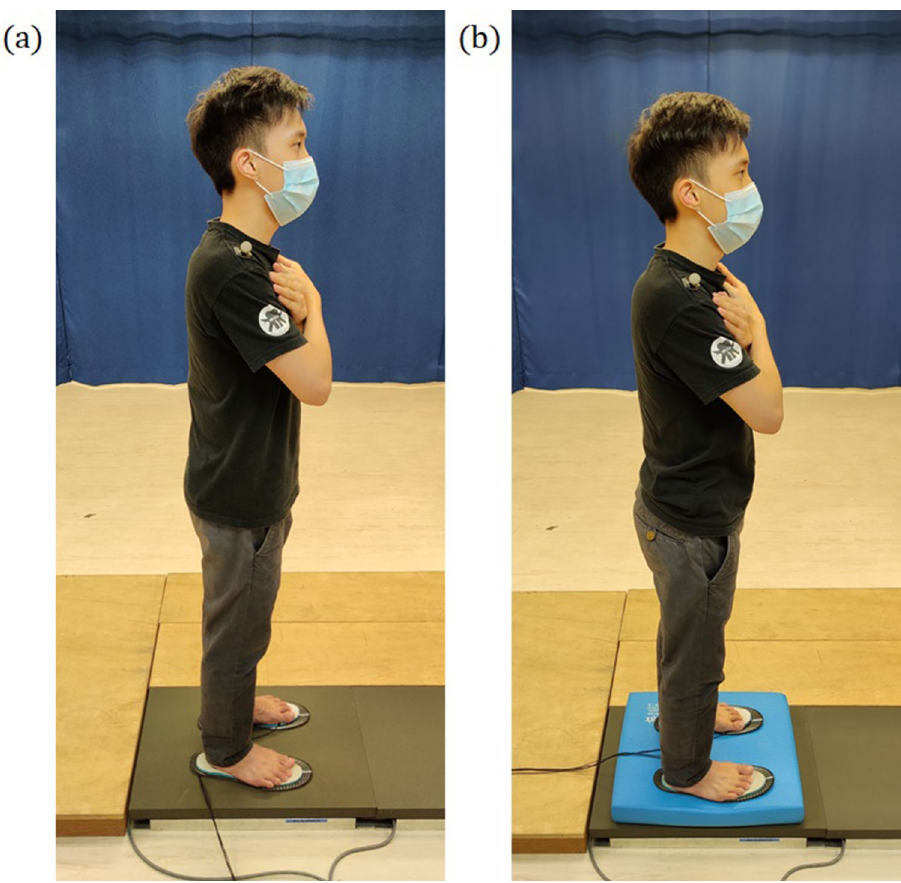
Figure 2. Subject posture during ( a ) firm surface and ( b ) compliant surface balance trials, with the reflective marker placed on the right